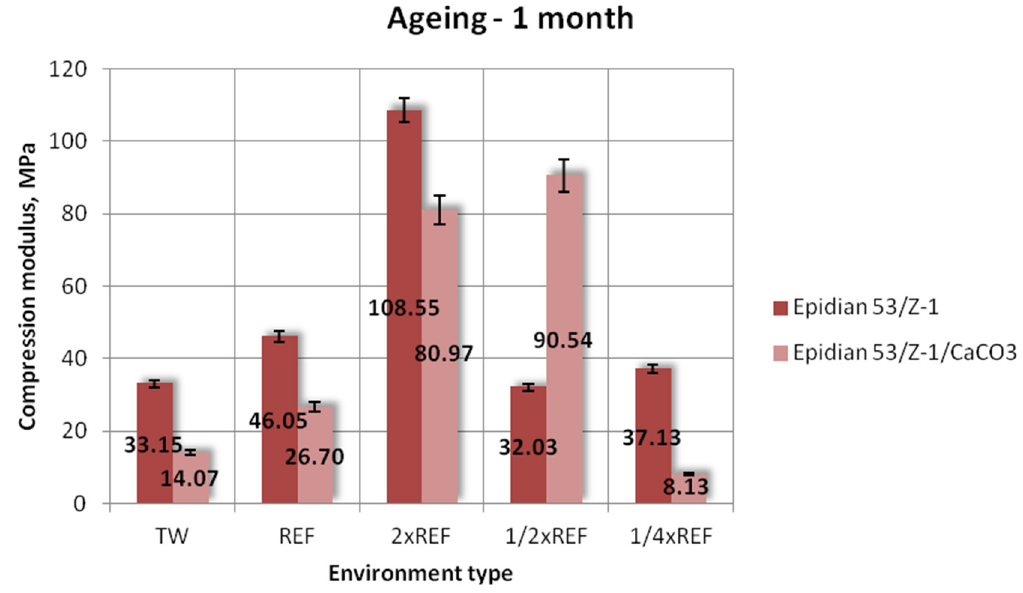
Figure 7. Compression modulus of the unmodified (Epidian 53/Z-1) and modified (Epidian 53/Z- 1/CaCO 3 ) epoxy adhesive compounds, aged for 1